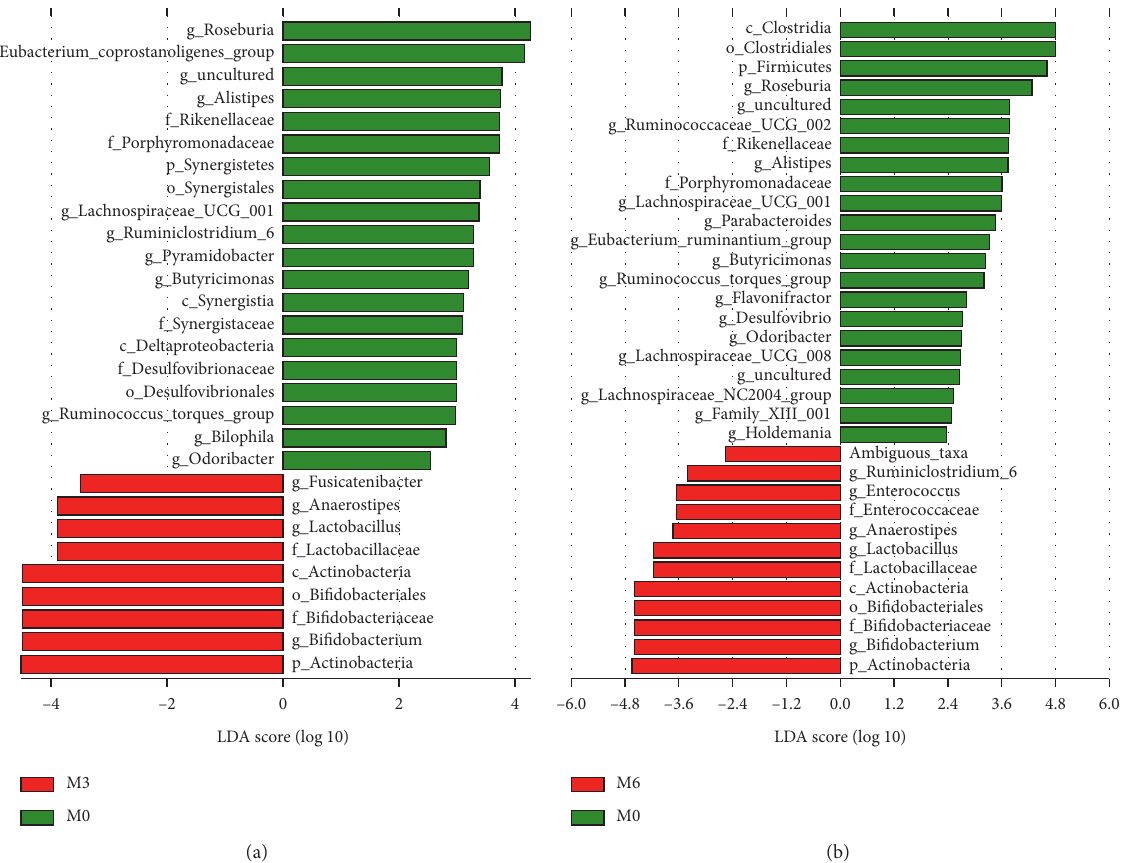
Figure 3: The LEfSe analysis of the gut microbiota from the phylum level down to the genus level. (a) M0 vs. M3; (b) M0 vs. M6. M0, baseline; M3, at three months after inulin intervention; M6, at six months after inulin intervention.